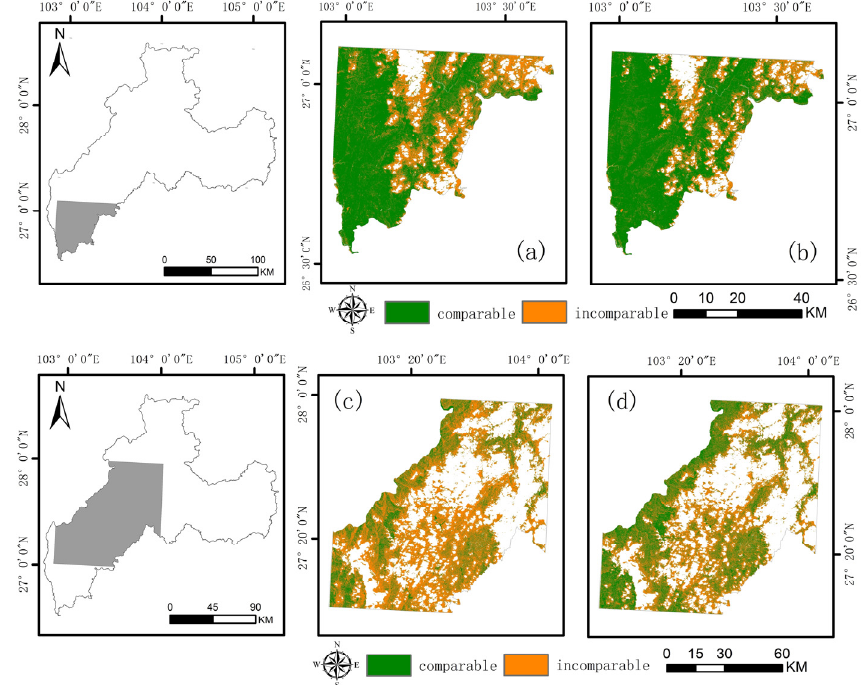
Figure 14. ( a ) True difference image under the same sensor, i.e., the difference between the pixels of the benchmark image and the image to be corrected; ( b ) Corrected difference image under the same sensor, i.e., the difference between the pixels of the benchmark image and the corrected image. ( c ) True difference image under different sensors; ( d ) Corrected difference image under different sensors. Pixels with − 0.02 ≤ difference ≤ 0.02 are defined as comparable; the rest of the pixels are incomparable. Table 7. Statistics of the pixel’s mean values of the di ff erence images from same sensor and from di ff erent sensors.